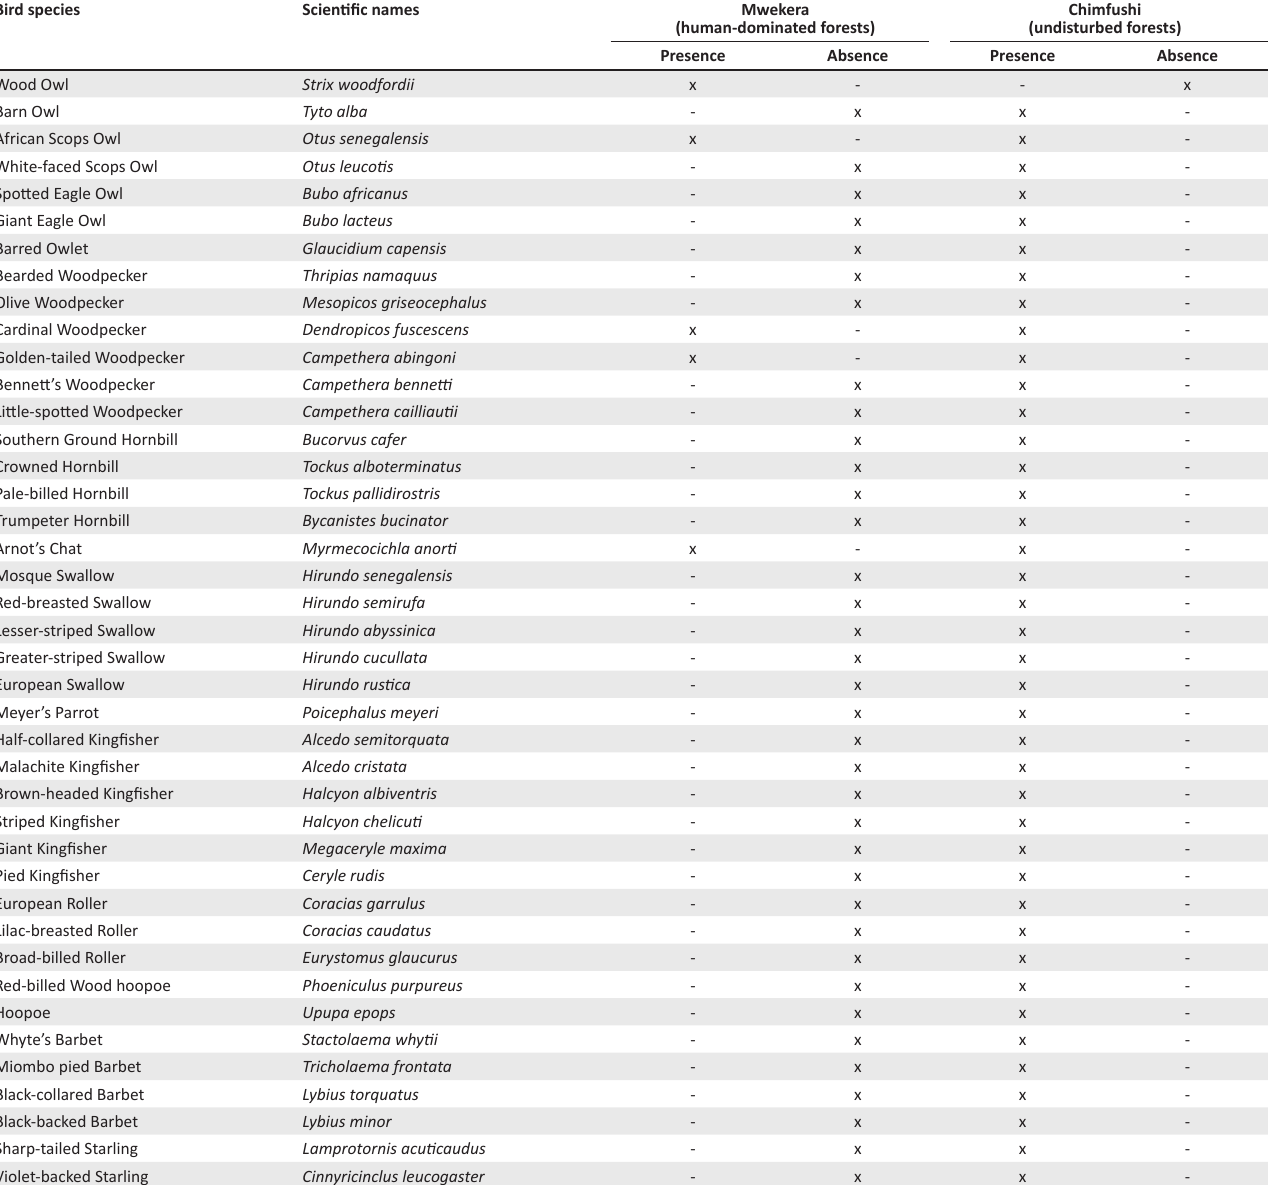
TABLE 1: Presence and absence of key cavity-nesting birds in Mwekera National Forests No. 6 and the Chimfushi Wildlife Orphanage forests, Copperbelt Province, Zambia, 2014. Bird